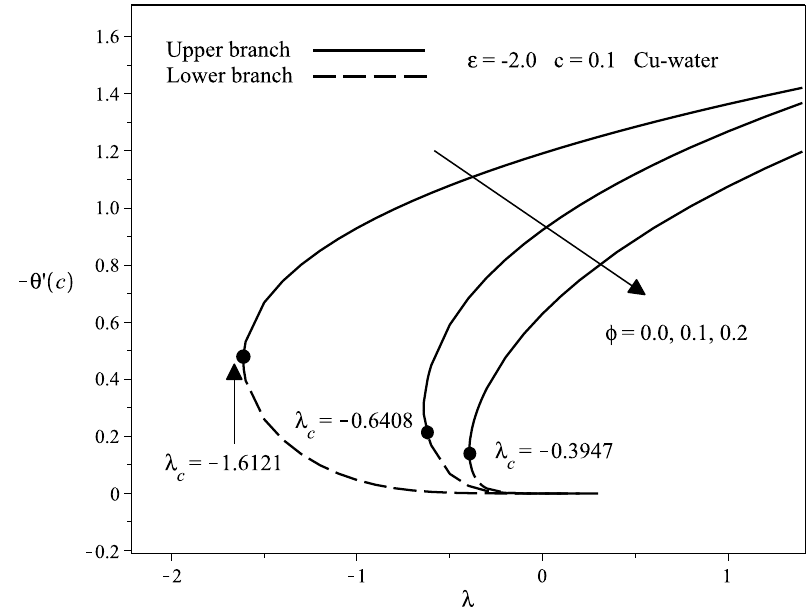
Figure 3. Effect of mixed convection parameter λ on the variation of local heat flux for various values of nanoparticle volume fraction φ .